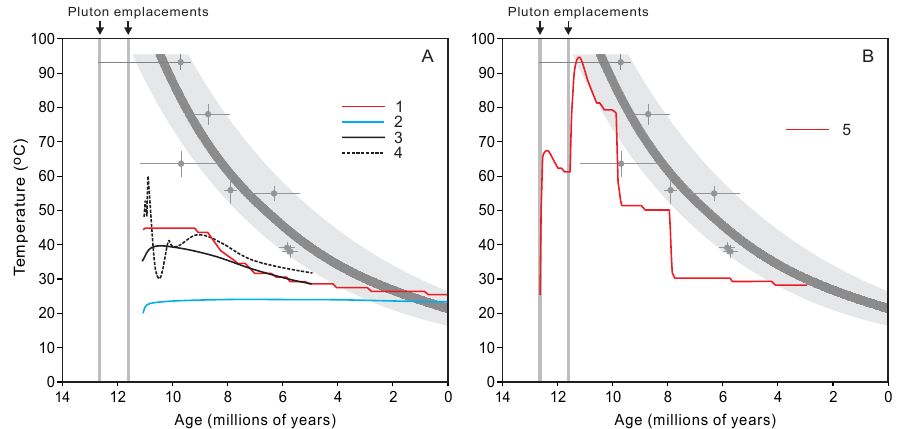
Figure 4. Results of thermal modeling (MICH model): (a) 2001–2007; (b) 2008. (1) Lateral distance from pluton 4km, depth 250m, convection above magma chamber allowed (Marshall and Whelan, 2001; HEAT3D). (2) Lateral distance 4km, depth 380m, conduction only (Dobson, 2003; TOUGH2); (3) Lateral distance 7km, depth ca. 250m, conduction only (Dublyansky and Polyansky, 2007; HEAT3D); (4) Lateral distance 7km, depth ca. 250m, simulation includes effects of water convection, lateral advective flow of water, and flow in fault zones confining the Yucca Mountain tectonic block (Dublyansky and Polyansky, 2007; HYDROTHERM); (5) Lateral distance 8km, depth decreases from 300m at 11.5Ma to 200m at present, water convection is allowed (Whelan et al., 2008; HEAT3D). The thick grey line, grey field and circles with error bars show the benchmark as updated in this